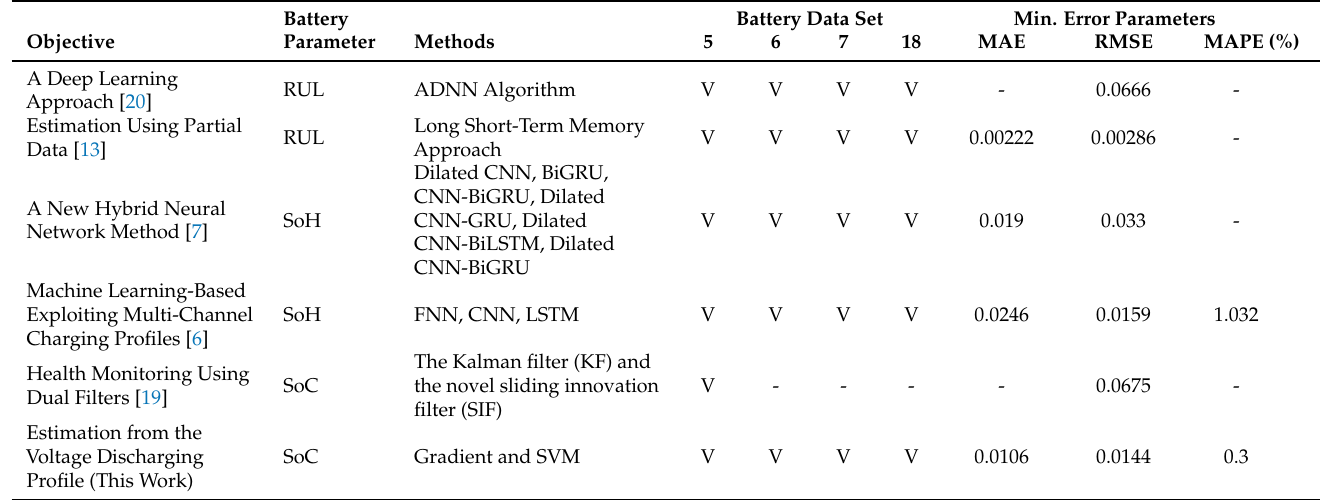
Table 5. Error report from using Nasa battery data set.